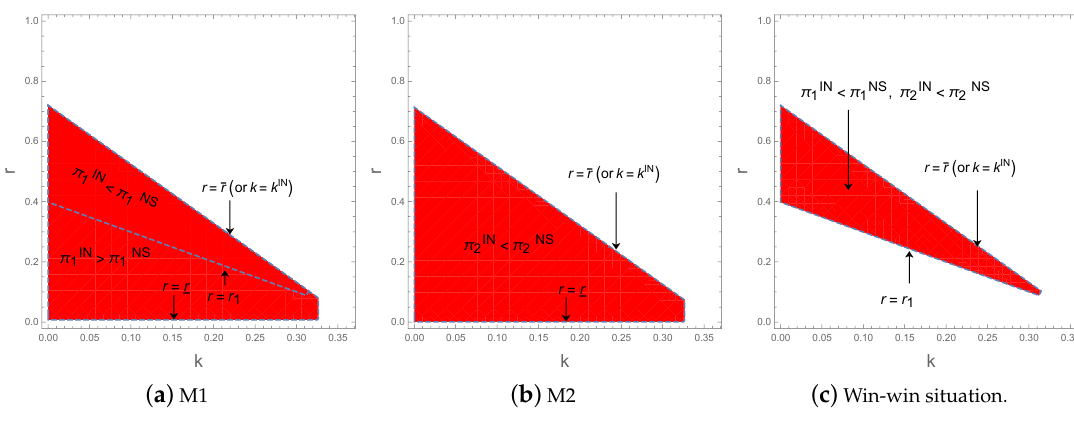
Figure 2. The profitability